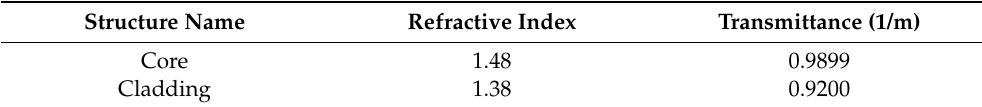
Table 3. Material properties of